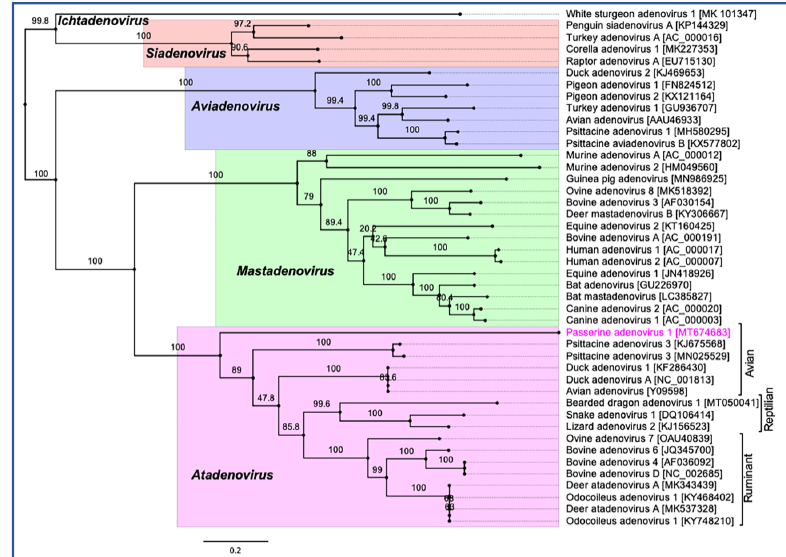
Figure 4. Phylogenetic tree shows the possible evolutionary relationship of novel passerine adenovirus 1 with other selected AdVs. Maximum likelihood (ML) tree was constructed by using concatenated amino acid sequences of the complete DNA-dependent DNA polymerase, pTP, penton, and hexon genes. Concatenated protein sequences were